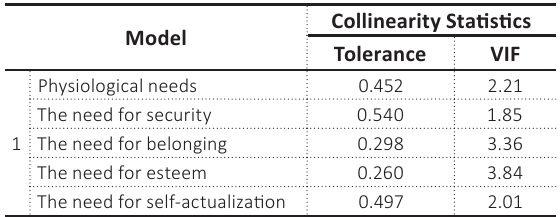
Table 1. Collinearity Test a